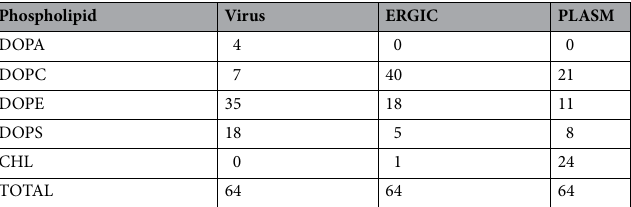
Table 1. The number of phospholipids in each membrane. DOPA dioleoyl-phosphatidic acid, DOPC dioleoyl- phosphatidyl choline, DOPE dioleoyl-phosphatidyl ethanolamine, DOPS dioleoyl-phosphatidyl choline, CHL